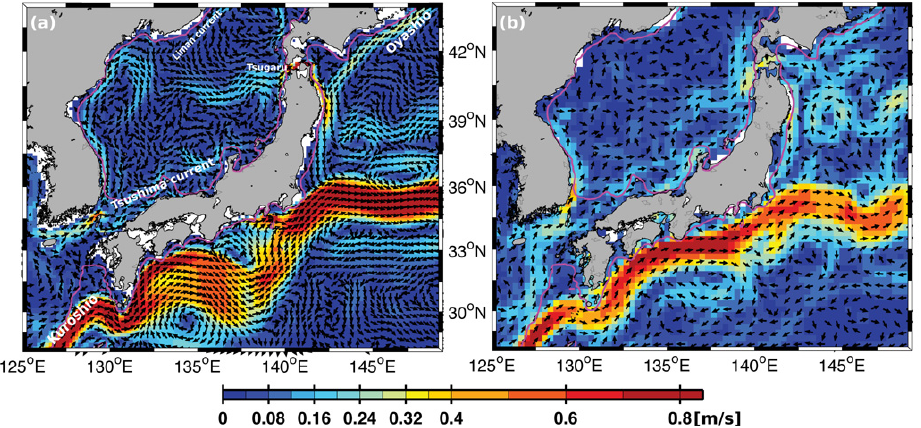
Fig. 3. Surface currents, averaged over the period 1994 to 1996. The color shading denotes absolute velocity. The arrows indicate the direction of the currents. The magenta line is the 200m isobath. Panel (a) shows simulated velocities. The actual model resolution is three times higher (in both meridional and zonal direction) than indicated by the arrows. Panel (b) shows geostrophic velocities as estimated from space (Aviso,